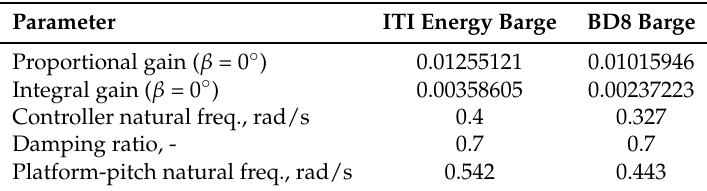
Table 2. Blade-pitch detuned PI control loop